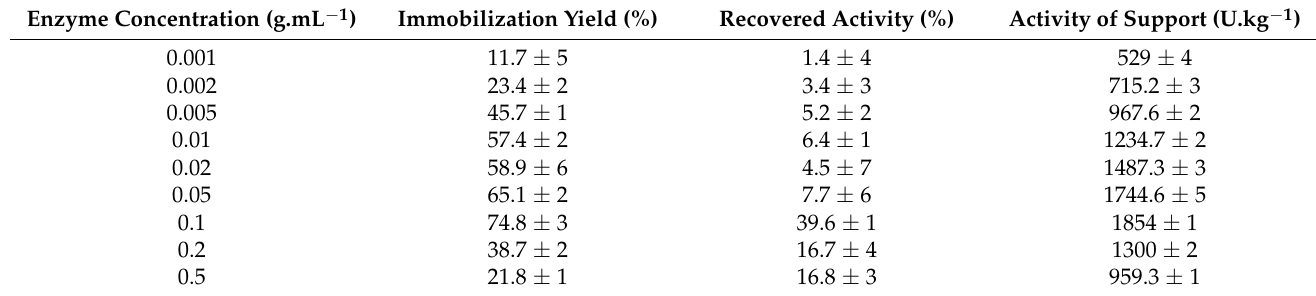
Table 1. Influence of initial enzyme concentration on immobilization yield and recovered activity. Enzyme Concentration (g.mL − 1 ) Immobilization Yield (%) Recovered Activity (%) Activity of Support (U.kg − 1 )